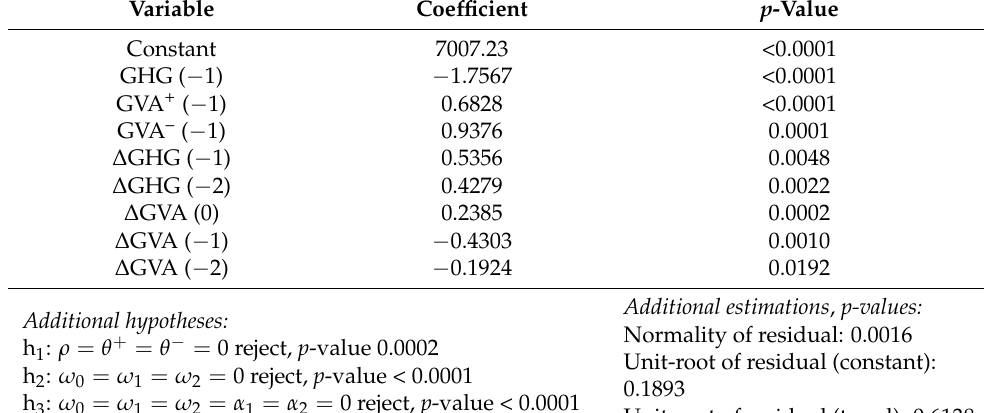
Table A2. NARDL results for Lithuania after sequentially omitting insignificant variables.